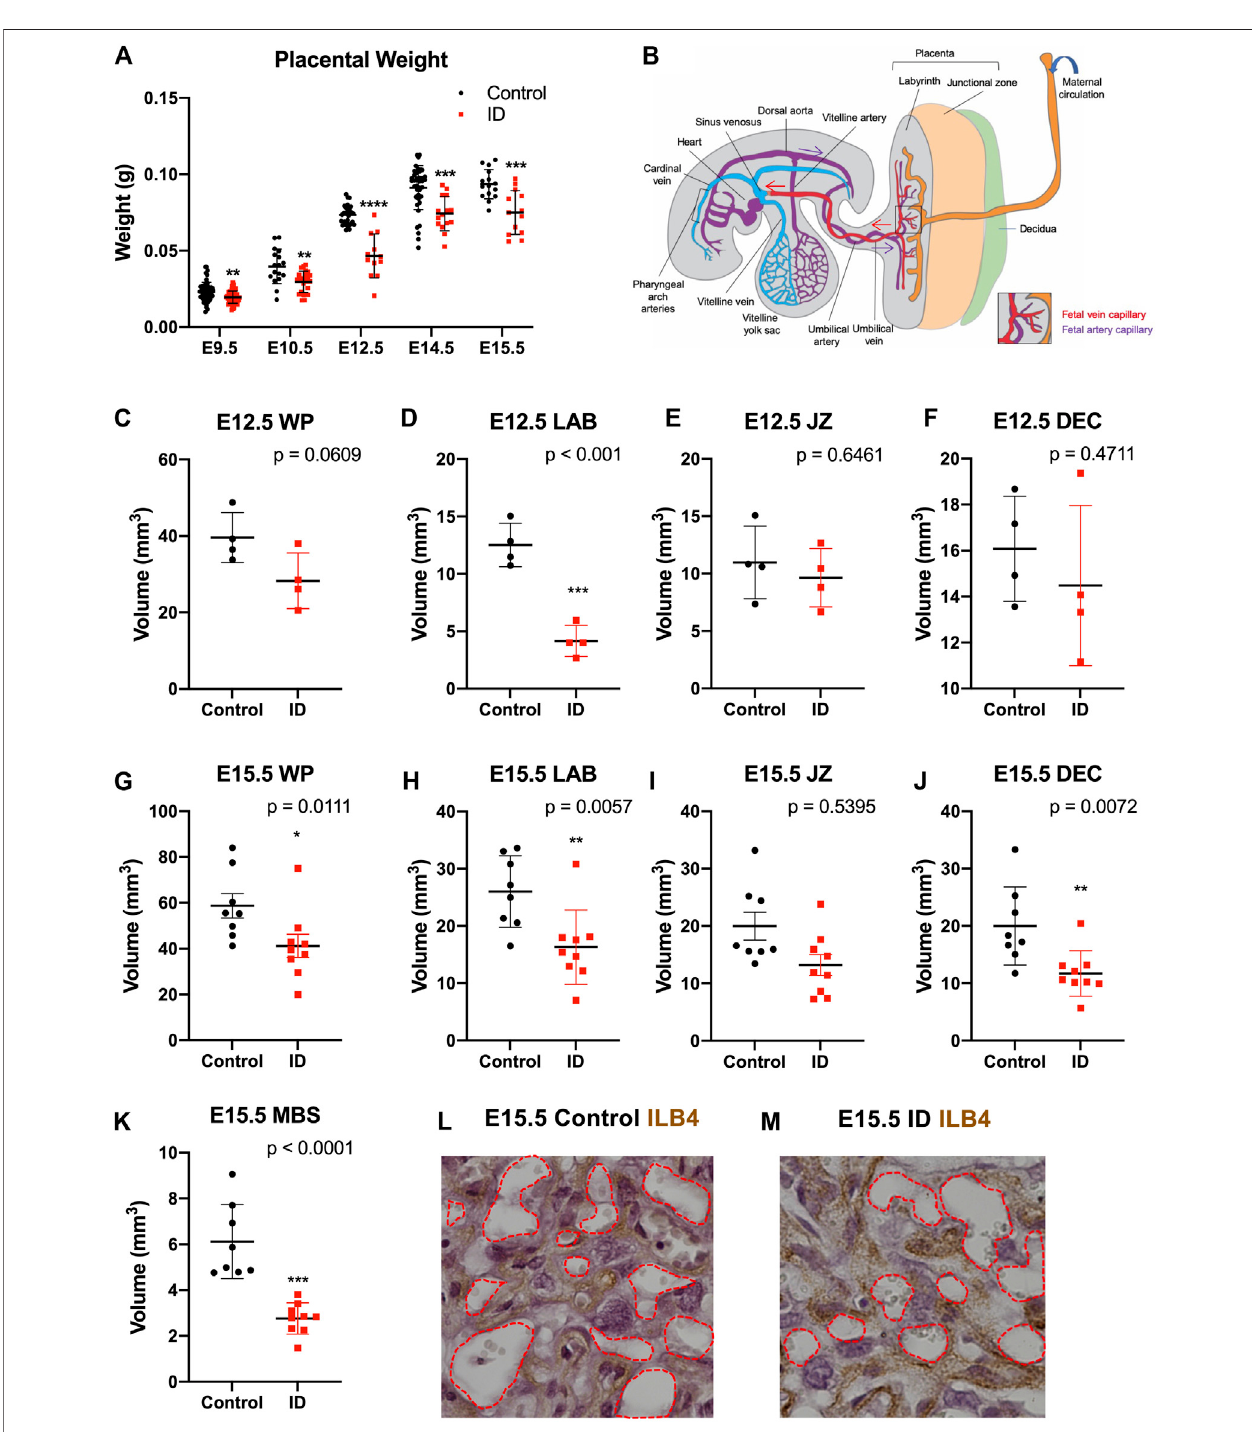
FIGURE 2 | Maternal iron de fi ciency impacts placental formation, particularly to the labyrinth vasculature . (A) Placental wet weights from E9.5 to E15.5. After ID, placentas weighed less, most signi fi cantly at E12.5 (onset of embryonic death). Placental weights remained reduced to E15.5. (B) Diagrammatic representation of placenta-fetal blood fl ow in the mouse in mid-gestation with maternal blood spaces (orange), and fetal capillaries made up of PA (purple) and PV (red). Arrows show direction of blood fl ow. (C – F) Gross morphological volumes of placental compartments at E12.5 for whole placenta [WP, (C) ], labyrinth [LAB, (D) ], junctional zone [JZ, (E) ],and decidua [DEC, (F) ].Labyrinth volumeonly wasreducedafter ID. (G – L) Grossmorphological volumes ofplacental compartmentsat E15.5.Whole placental volumewasreduced (G) ,includingcompartmentsforthelabyrinth (H) anddecidua (J) .Maternalbloodspaces[MBS, (K) ]werequanti fi edasIsolectinB4(ILB4)negative stainingand werereducedatE15.5.ILB4stainingofE15.5placentas forcontrol (L) and ID (M) ,withreddashed linedemarcatingMBS. (A) Control: E9.5, n (cid:1) 58;E10.5, n (cid:1) 17; E12.5, n (cid:1) 32; E14.5, n (cid:1) 40; E15.5, n (cid:1) 15. ID: E9.5, n (cid:1) 59; E10.5, n (cid:1) 24; E12.5, n (cid:1) 12; E14.5, n (cid:1) 15; E15.5, n (cid:1) 13. (C – F) Control, n (cid:1) 4; ID, n (cid:1) 4. (G – K) Control, n (cid:1) 8; ID, n (cid:1) 9. Control (black dots) and ID (red squares). Data represented as mean ± SD. Data were analyzed by unpaired t -test unless otherwise stated. Mann – Whitney test was performed in A (E10.5 only), G – I. * p < 0.05, ** p < 0.01, *** p < 0.001, and **** p < 0.0001. ID, iron de fi cient.